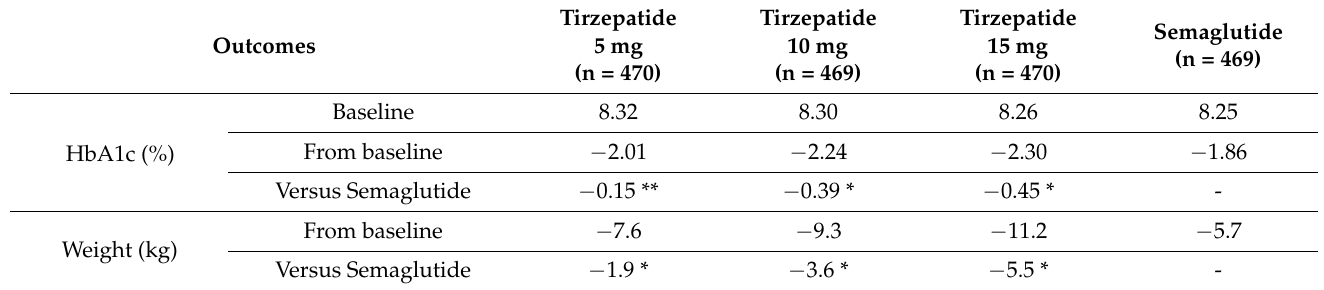
Table 2. Results of the SURPASS-2 trial at 40 weeks [41]. Efficacy analyses were performed in the mITT population; * p < 0.001; ** p =